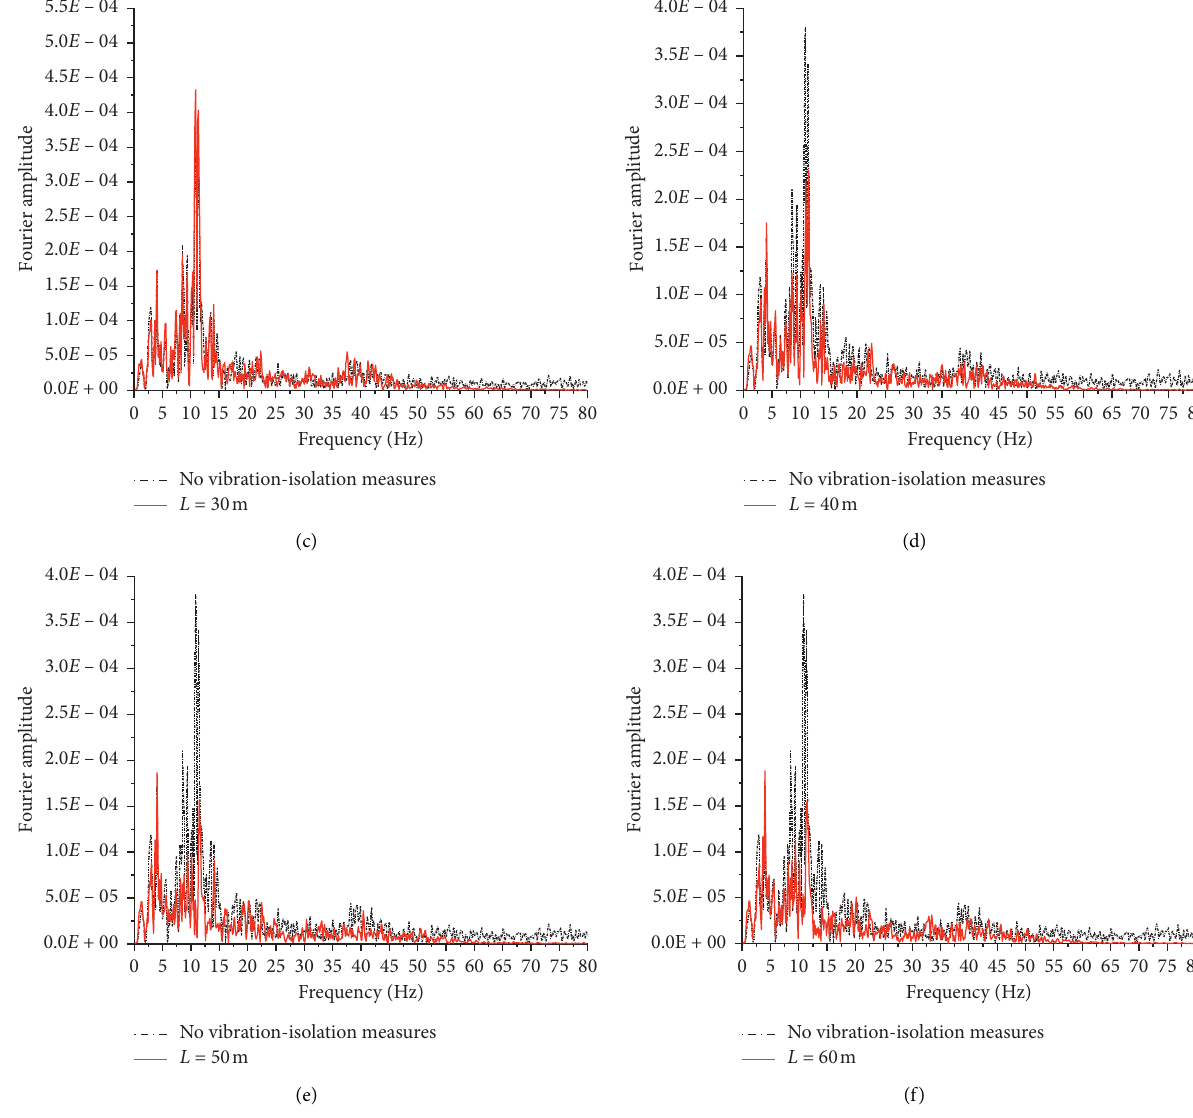
Figure 32: Influence of pile length ( L ) on vibration-isolation effect (comparison of frequency